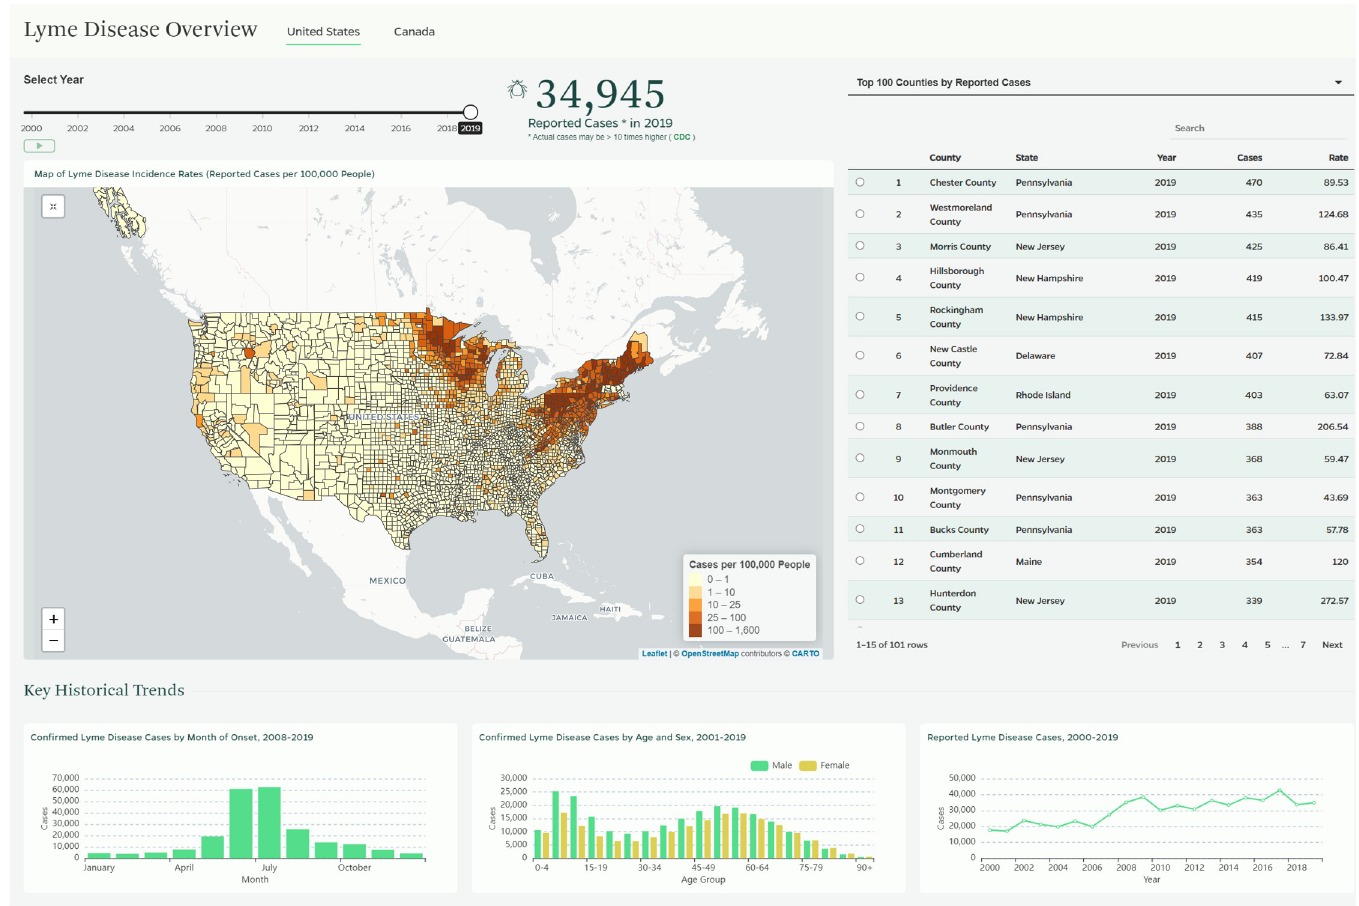
Fig 1. US view of “Lyme Map” application. The data in this figure are from CDC and the US Census Bureau and are in the public domain. Map tiles are reprinted under a CC BY license, with permission from CARTO, original copyright 2021. CARTO map tiles contain information from OpenStreetMap and OpenStreetMap Foundation, which is made available under the Open Database